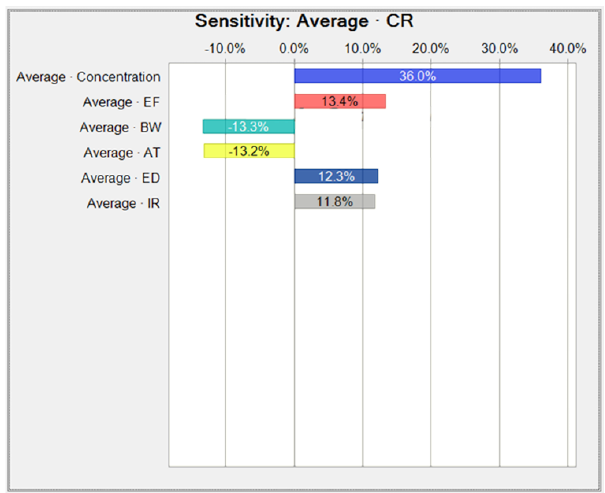
Figure A5. SA of LTCR model (children) for Ni in water.